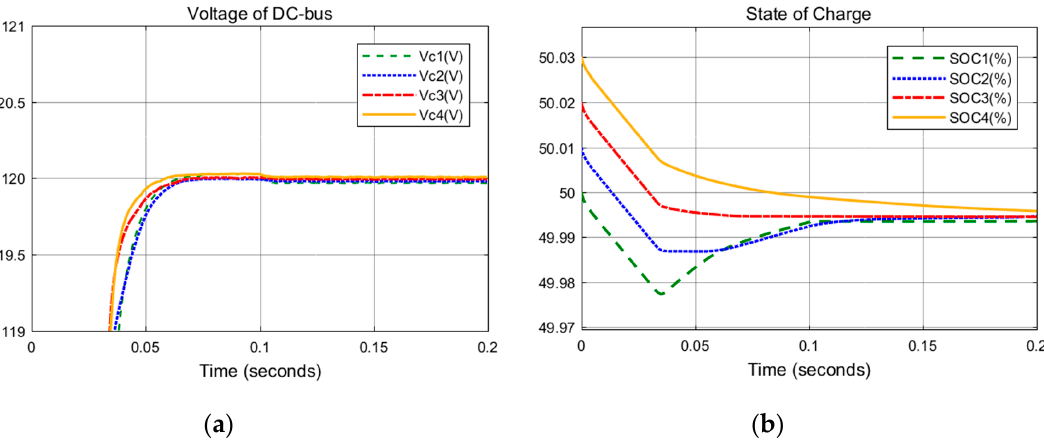
Figure 14. Distributed cooperative control when the load variation is at 0.1 s of DCES 1 : ( a ) DC-bus voltage; ( b ) battery SOC.